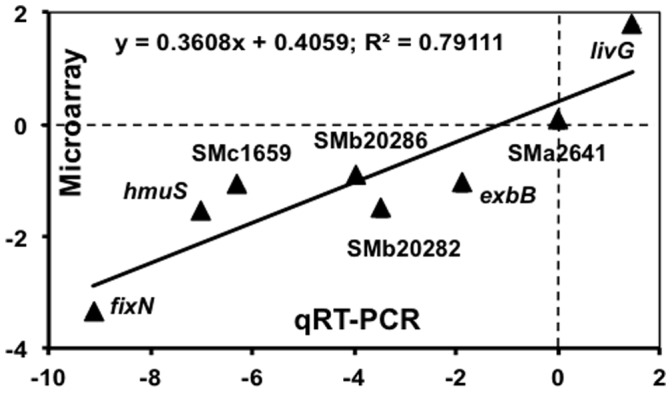
Comparison of log2-transformed microarray and qRT-PCR data of 7 representative genes differentially expressed in Rm1021 cells under high vs. low nitrogen.